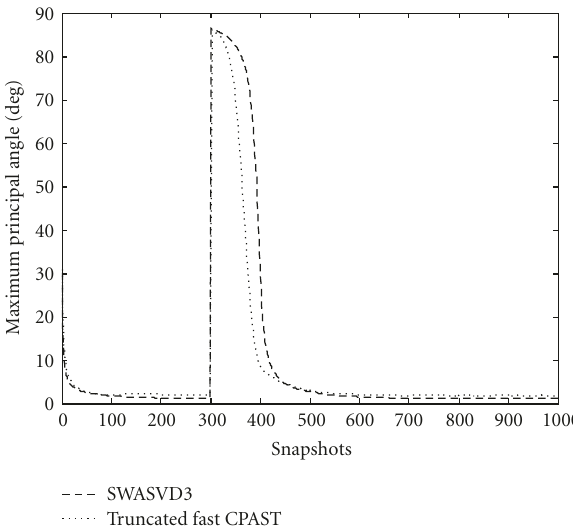
Figure 14: Maximum principal angle of the truncated fast CPAST and SWASVD3